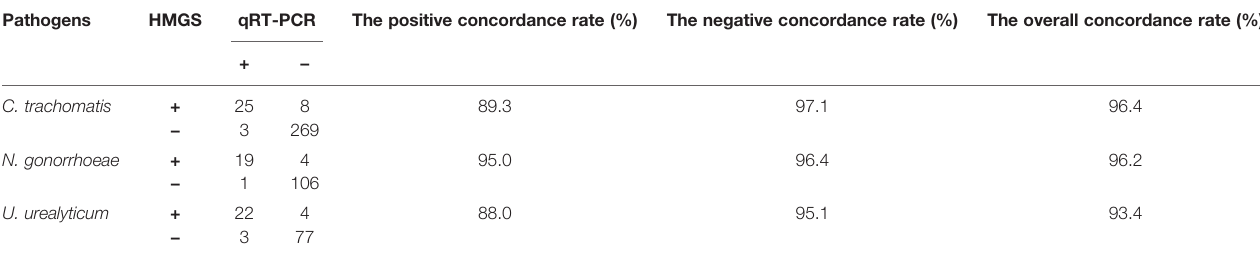
TABLE 4 | The concordance rates of detection results between STI-HMGS and qRT-PCR. Pathogens